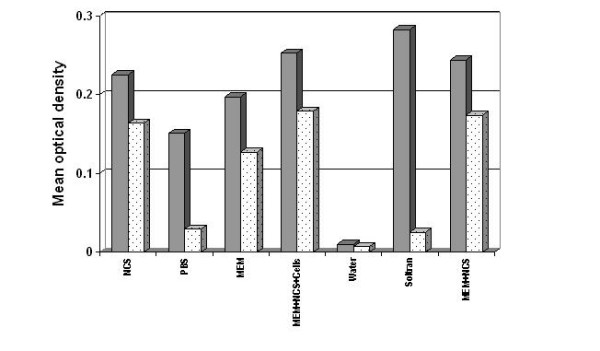
The viability of kidney biopsy tissue assessed by MTT assay. Mean optical density readings following incubation in preservative solutions at 1°C (shaded boxes) or 37°C (dotted boxes). See text for abbreviations.